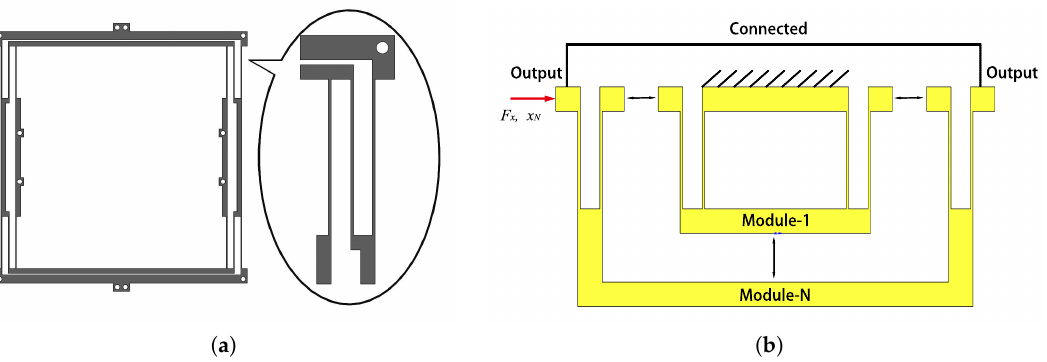
Figure 1. Illustrations of ( a ) basic structure and ( b ) multistage compound parallelogram flexure (MCPF) with N modules.